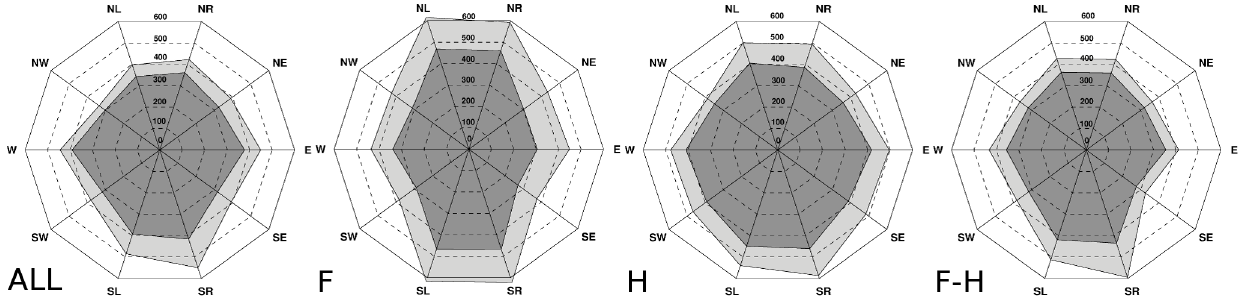
Figure 3. Mean Detection Time. The Figure shows the Mean Detection Time ( MDT ) obtained for each type of perturbation (i.e., NR , NE , E , SE , SR , NL , NW , W , SW , SL ) averaged across all participants (dark gray area) plus one standard deviation (light gray area) considering the all-segments ( ALL ), the feet ( F ), the hands ( H ) and the feet-hands ( F-H ) combinations. All the values are expressed in ms .